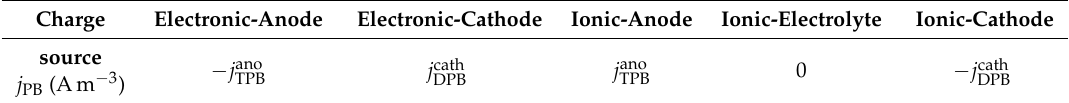
Table 12. Source terms for Equation